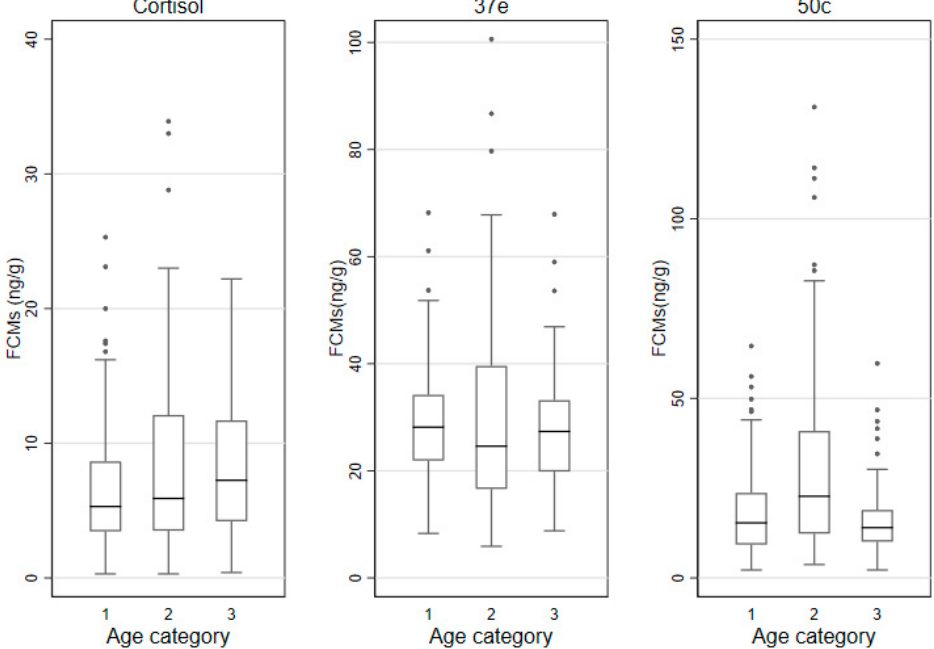
Figure 3. Box and whisker plots for FCM (faecal cortisol metabolite) levels (ng/g) measured with the cortisol, 37e (5 α - pregnane-3 β ,11 β ,21-triol-20-one) and 50c (tetrahydrocorticosterone) EIAs (enzyme immunoassays), as grouped by age categories (1: ≤ 2 years-; 2: >2–5 years-; 3: >5 years; defecations n = 124, n = 159 and n = 68 respectively).